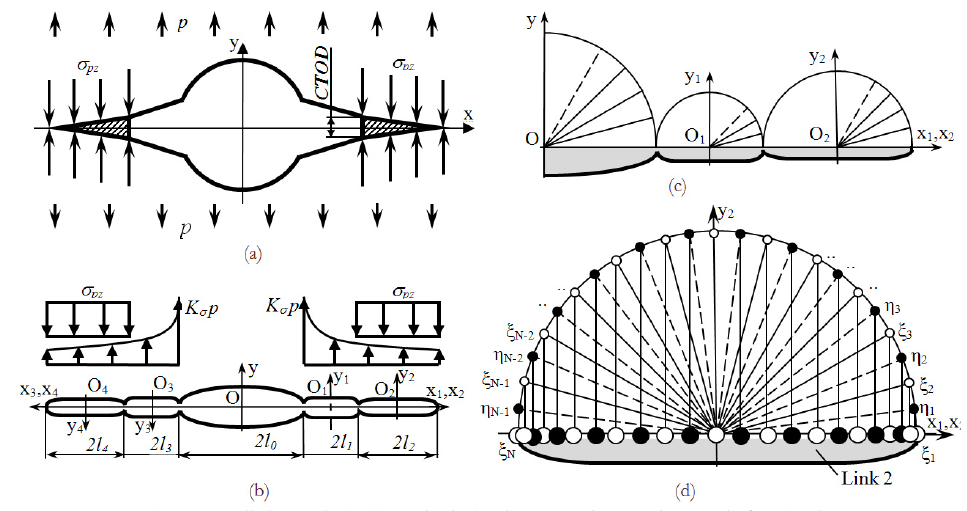
Figure 4: 5-link crack (a, b) and Chebyshev’s nodes on the crack face(c,